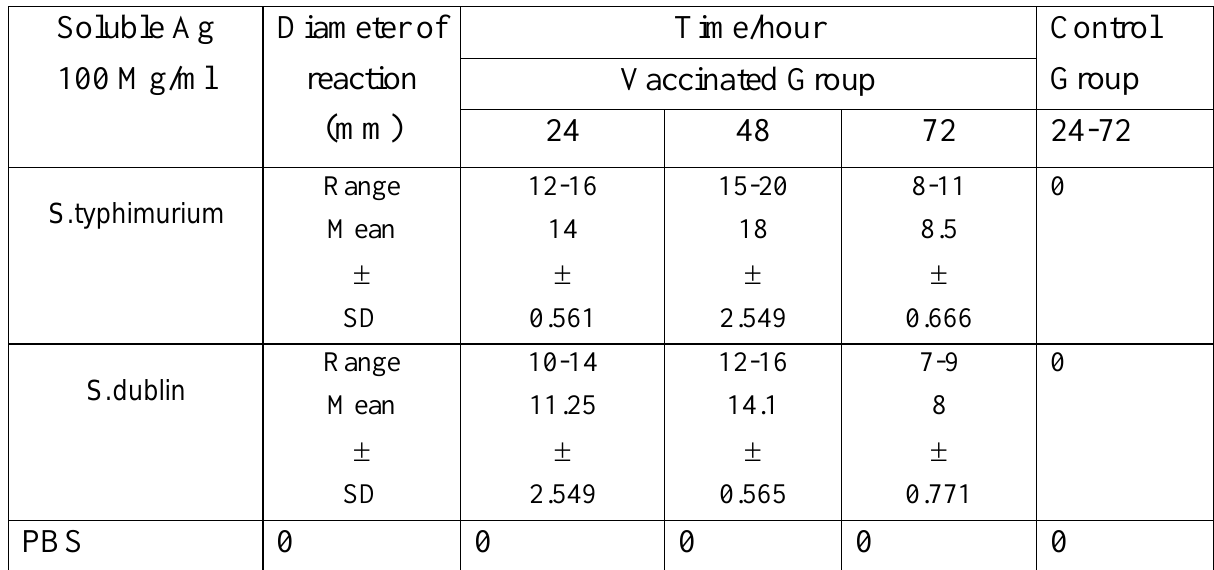
Table (1) DTH- skin reaction of the vaccinated pregnant G.pigs with